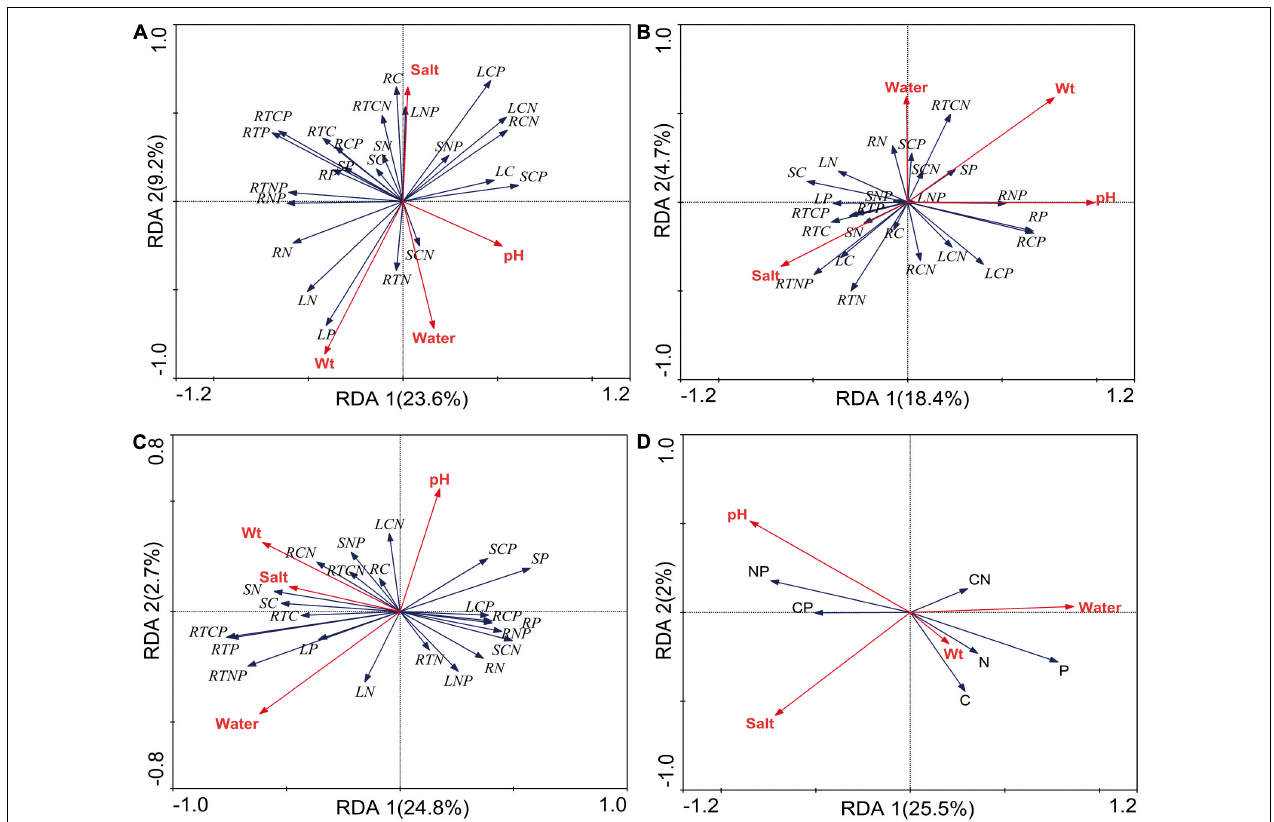
FIGURE 5 | Redundancy analysis (RDA) of the relationship between the P. australis stoichiometry and soil factors (A) wetland, (B) salt marsh, (C) desert, and (D) all habitats; Wt represent bulk density; L represent leaf, S represent stem, R represent rhizome, and RT represent root.